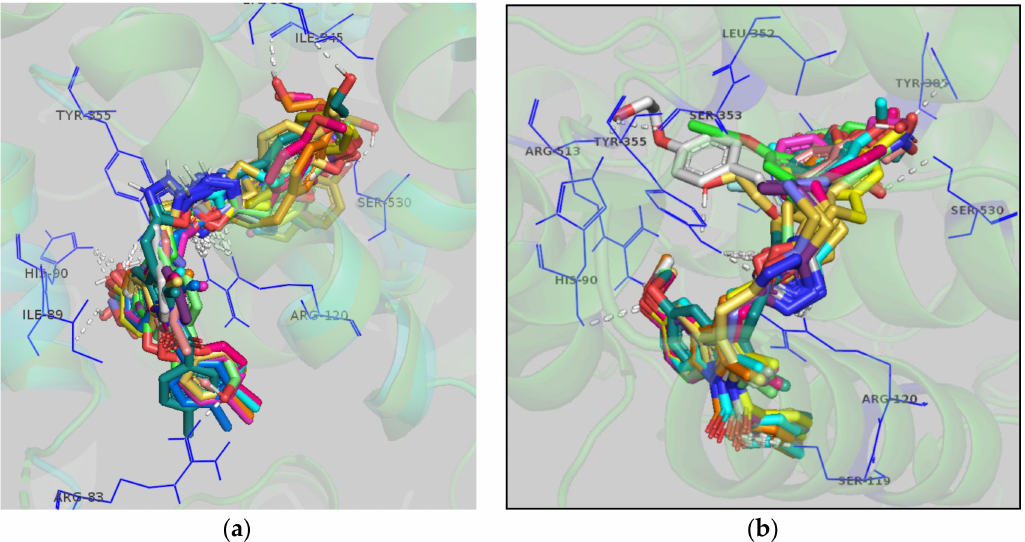
Figure 3. Binding mode of 8a–p to the active site of COX-1 ( a ) and COX-2 ( b